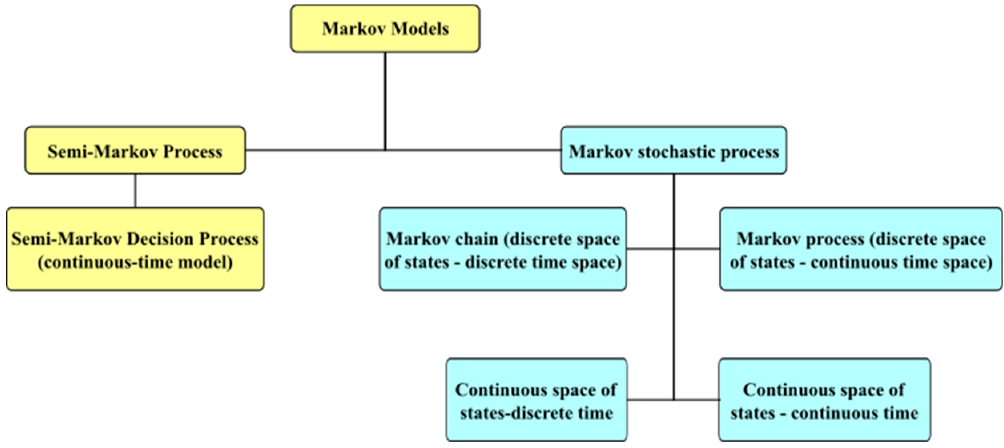
Figure 7. Markov models. “Source [16], own elaboration”.